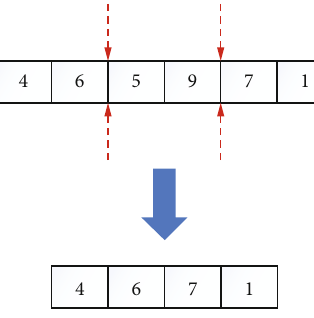
Figure 2: Random removal of two